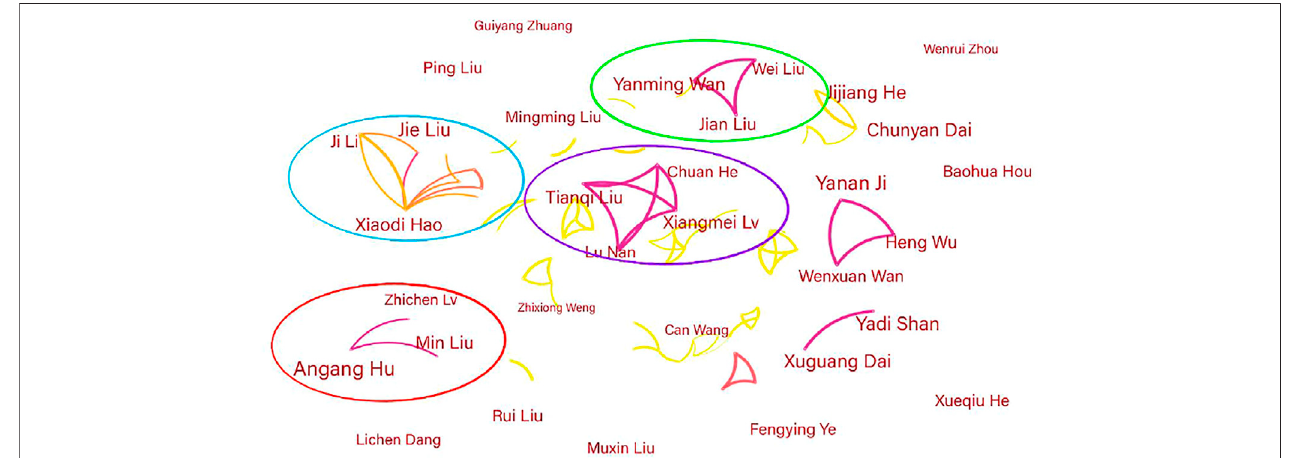
FIGURE 5 | Carbon neutrality study load author collaboration network diagram.